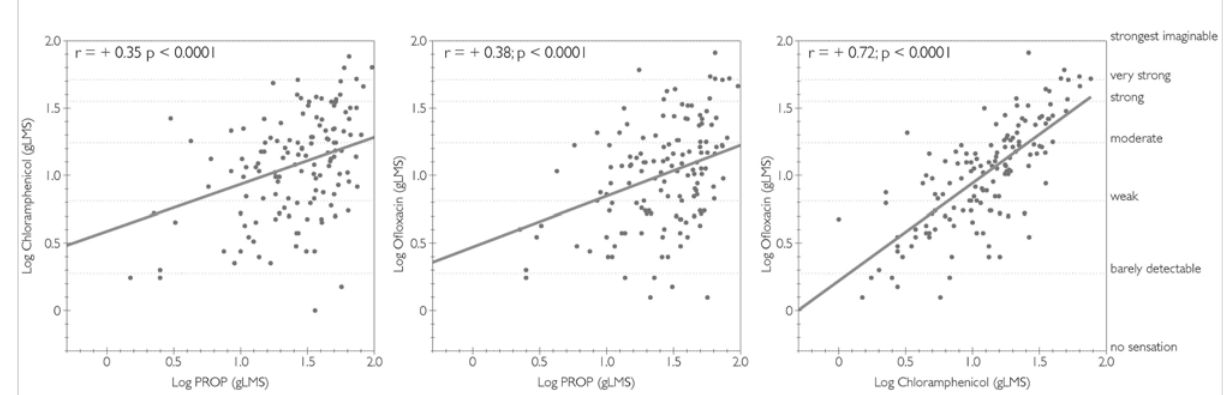
FIGURE 1 Correlationsoflogged bitternessratings between chloramphenicol, o fl oxacin, andPROP. Adjectiveson therighty-axis referto semanticlabels on a gLMS.